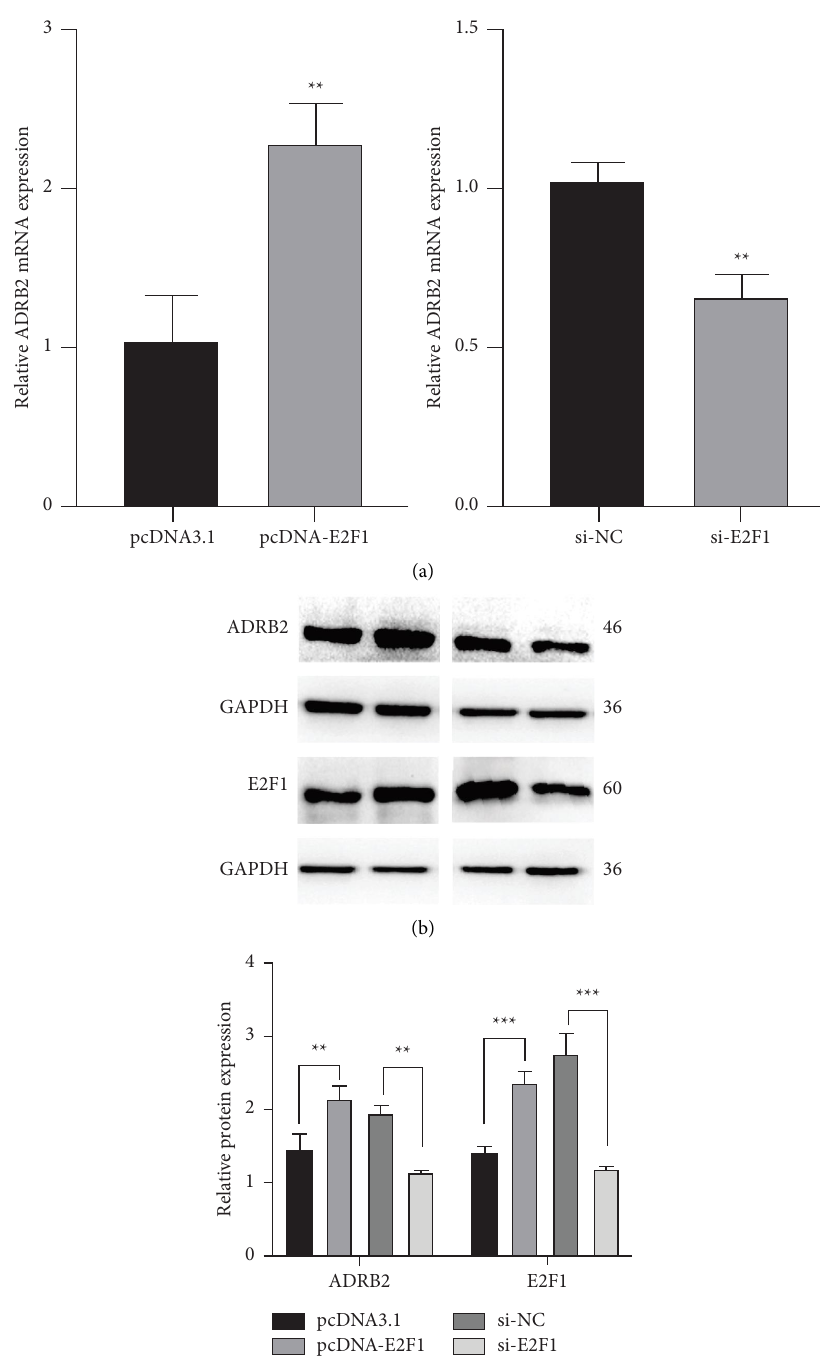
Figure 4: E2F1 upregulates the expression of human ADRB2 gene. (a) BEAS-2B cells were seeded in 12-well plates at a concentration of 1.5 × 105 cells per well 24h before pcDNA-E2F1 or si-E2F1. After 24h, cells were harvested for RNA, and reverse-transcription was performed to obtain cDNA for qRT-PCR. GAPDH was utilized as a housekeeping gene for calibration ( ∗∗ P < 0 . 01). BEAS-2B cells were seeded in 6-well plates at a concentration of 3.0 × 10 5 cells per well and pretreated with the same condition, as described above. Forty-eight hours after transfection, cells were harvested and subjected to Western blot analysis. Equivalent amounts of total cell proteins were fractionated by SDS-PAGE and probed with antibodies specifc for ADRB2, E2F1, and GAPDH. Te band was visualized with the ECL reagent (b) and further analyzed utilizing Image J (c, ∗∗ P < 0 . 01, ∗∗∗ P < 0 .